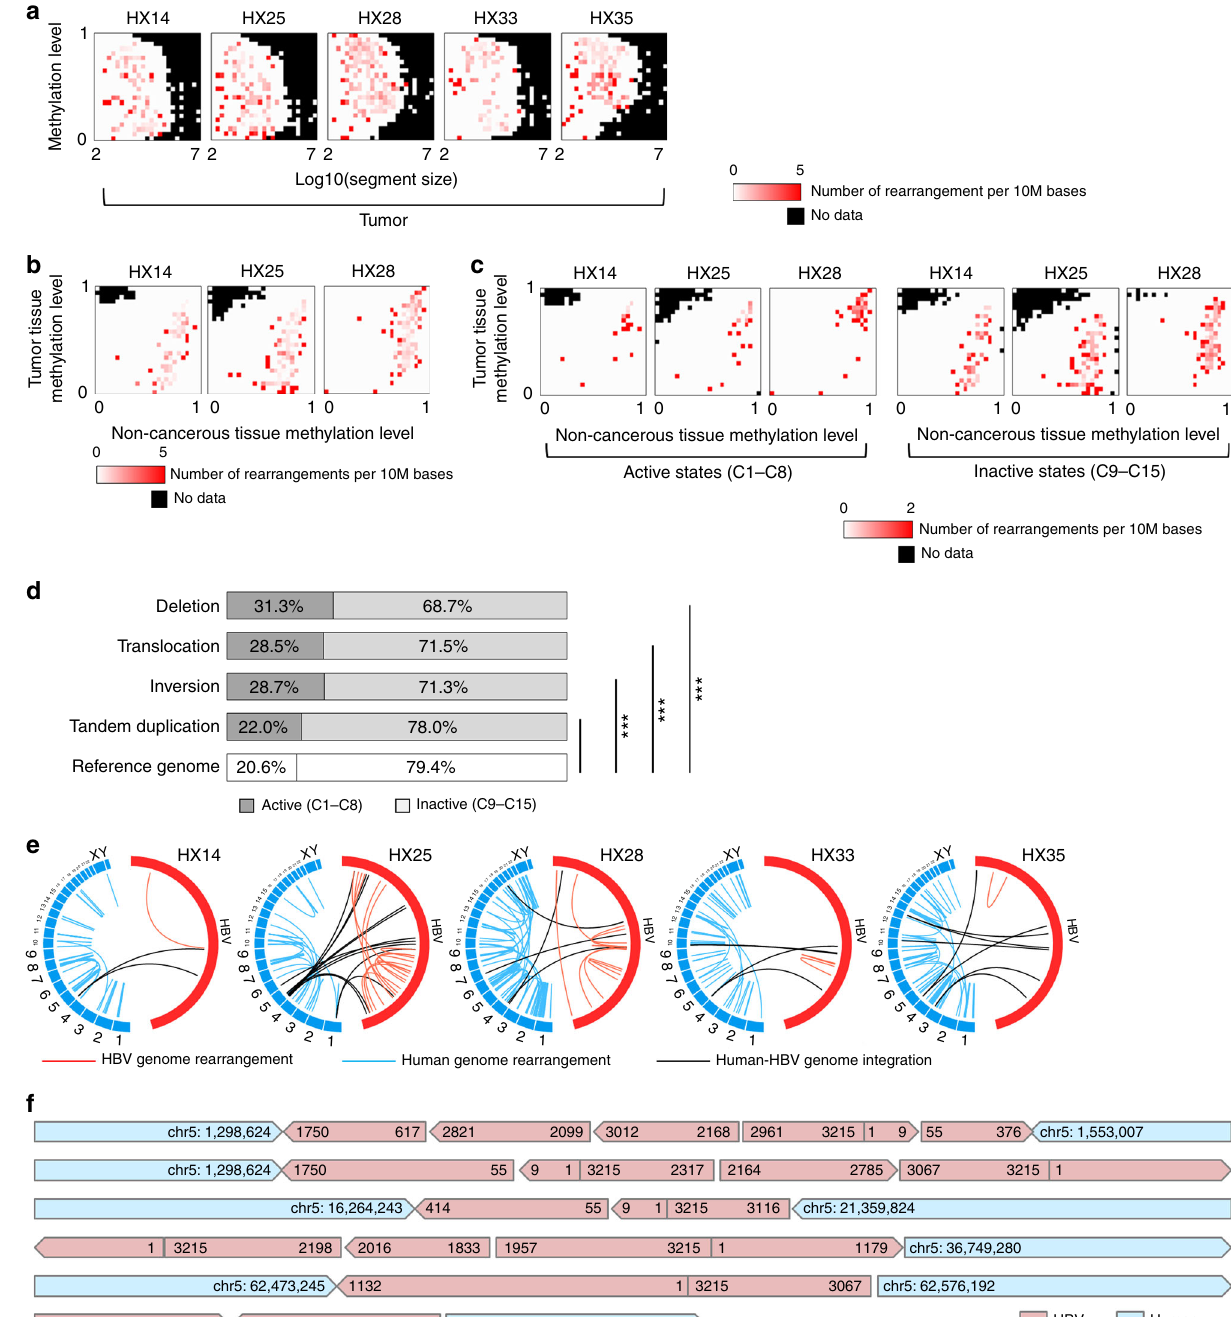
Fig. 6 Somatic structural alterations of the cancer and integrated virus genomes. a The density of somatic rearrangements in fi ve tumor samples. The color indicates the number of rearrangements per 10 million bases calculated for each fraction of the images in Supplementary Fig. 5a, which were divided into 25 × 25 areas. The x -axis indicates the size of the region and the y -axis indicates the methylation level of the region. All rearrangements in these samples are shown in Supplementary Data 1. b Accumulation of rearrangements according to different methylation levels of tumor ( y -axis) and non-cancerous ( x - axis) genomes. Red indicates the number of rearrangements per 10 million bases calculated for each fraction of the images in the upper left in Fig. 1a. c Comparison of the accumulation of rearrangements between active and inactive chromatin areas. d The proportion of somatic rearrangements in active and inactive chromatin areas analyzed using whole-genome sequencing (WGS) of 21 HCCs. In the active areas, deletions, translocations, and inversions were signi fi cantly enriched compared with those in the inactive areas. * P < 0.05, ** P < 0.005, *** P < 0.0005 using the Χ 2 -test. e Structural rearrangements of the HBV and human genomes in fi ve samples. Red line: HBV internal rearrangement; black: HBV and human genome breakpoint; blue: human genome rearrangement. f Six long reads from PacBio WGS of the HX25 tumor, including the complex rearrangement of viral and human genome sequences. The integrated or rearranged site was validated by at least two short reads obtained by the Illumina